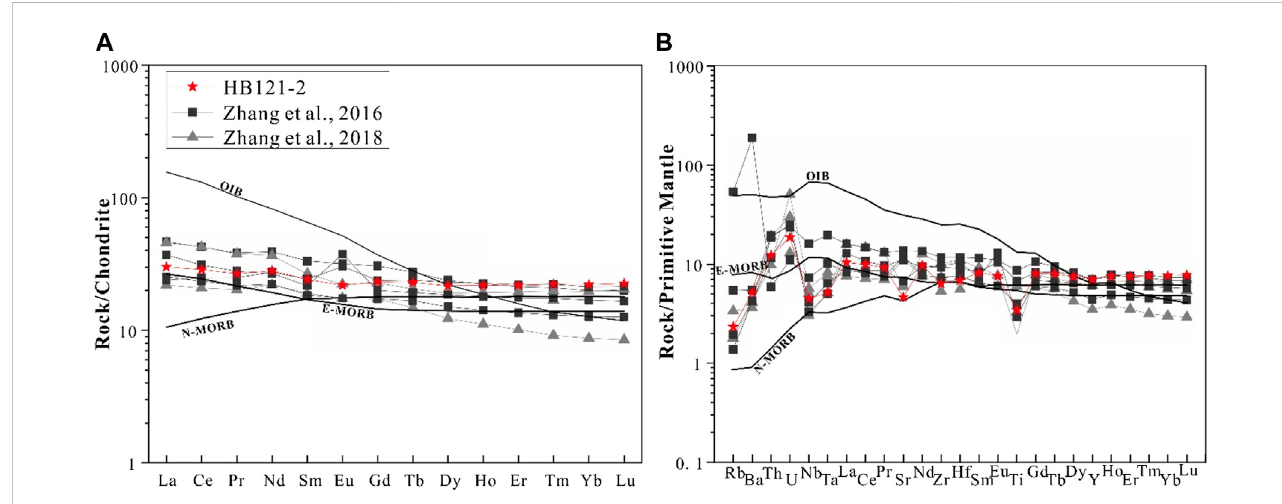
FIGURE 3 Chondrite-normalized REE pattern (A) and primitive mantle-normalized trace element pattern (B) of eclogites from the Western Tianshan UHP metamorphic belt in northwestern China. Normalization-values are taken from Sun and McDonough